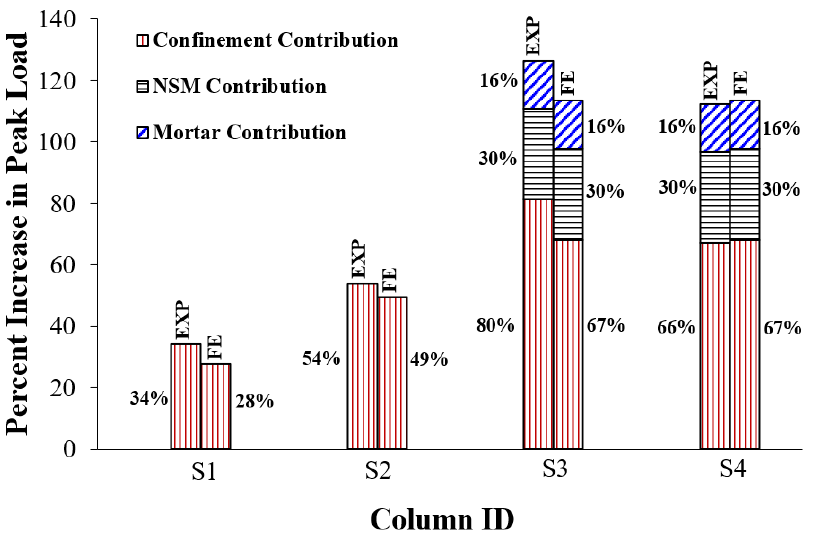
Figure 21. Effect of the contribution of different components on the percent increase in peak load for Figure 21. E ff ect of the contribution of di ff erent components on the percent increase in peak load for upgraded columns. upgraded